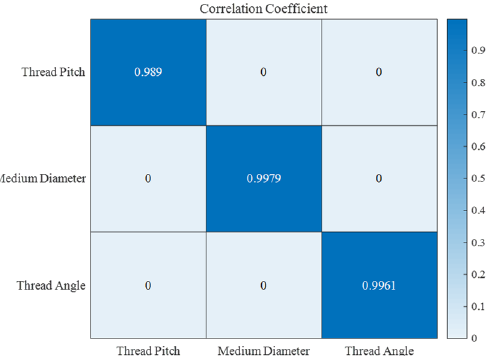
Figure 13. Correlation of the change in preload with the change in friction radius.